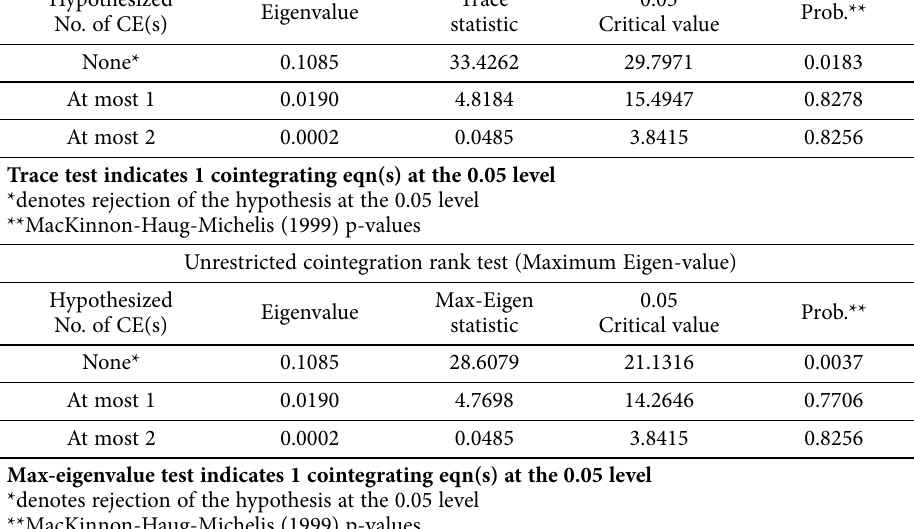
Table 4. Cointegration condition for LKSE, LCPI & LCOP Unrestricted cointegration rank test (Trace)